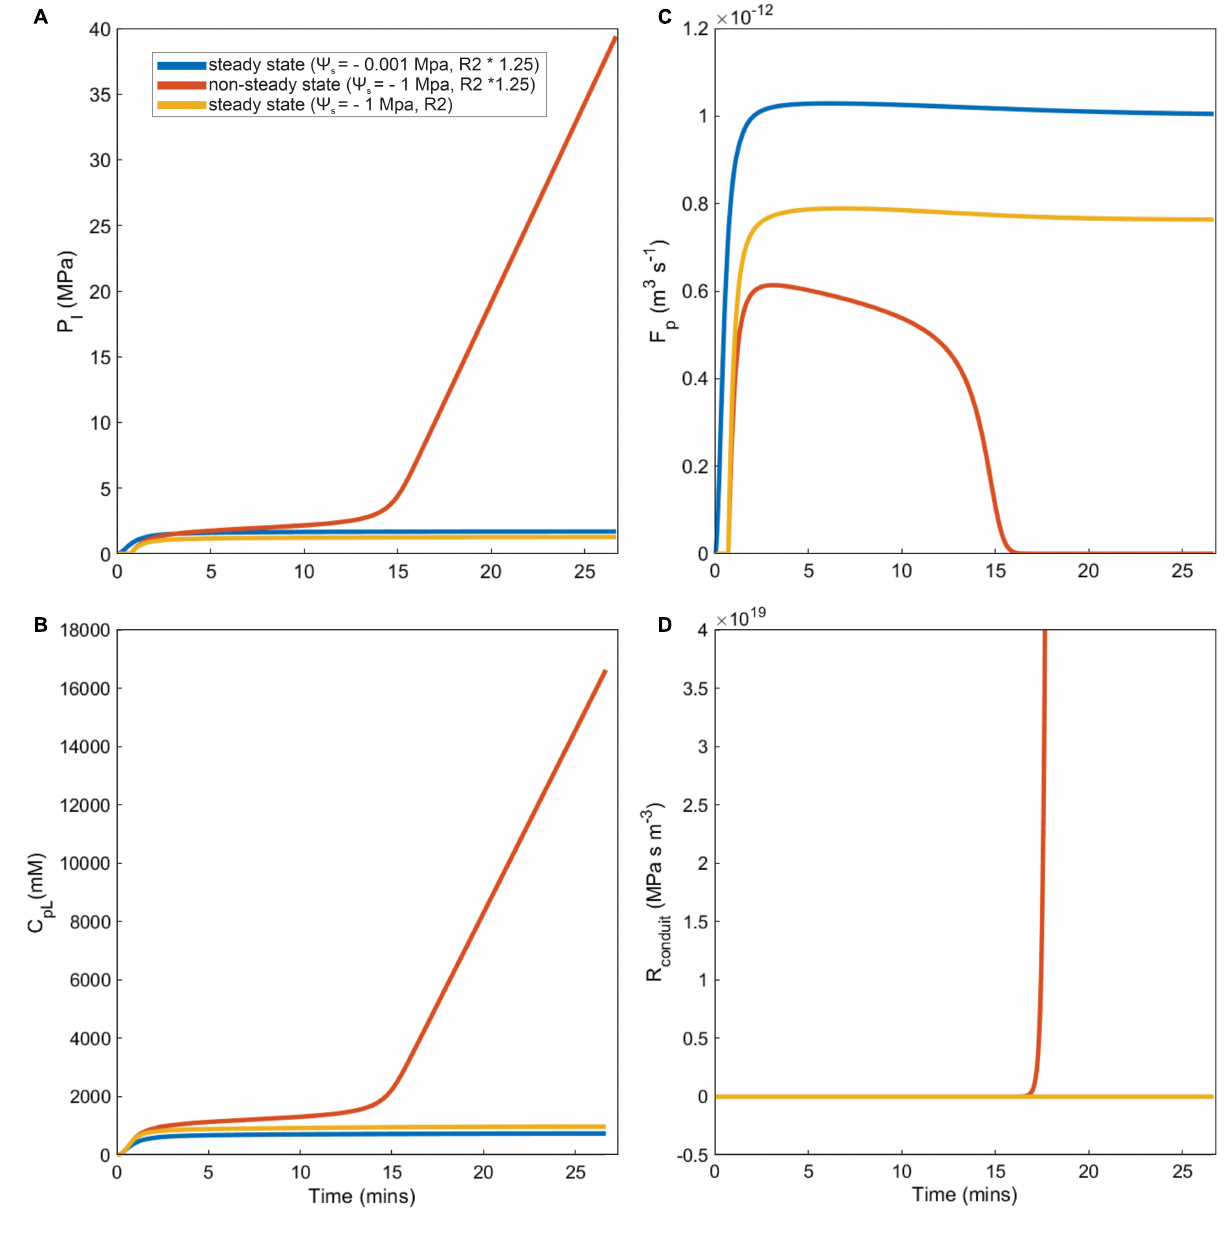
modulated according to these anatomical constraints, by either downregulating V maxL constitutively ( Figures 6A,C ) or inducibly as a function of pressure ( Figures 6C,D ). Reducing the maximum loading rate by half (V maxL ) reduced sucrose output to sinks ( Figure 6A ) in comparison to the non-regulated loading, but lowered phloem pressures to reasonable bounds ( Figure 6C , red